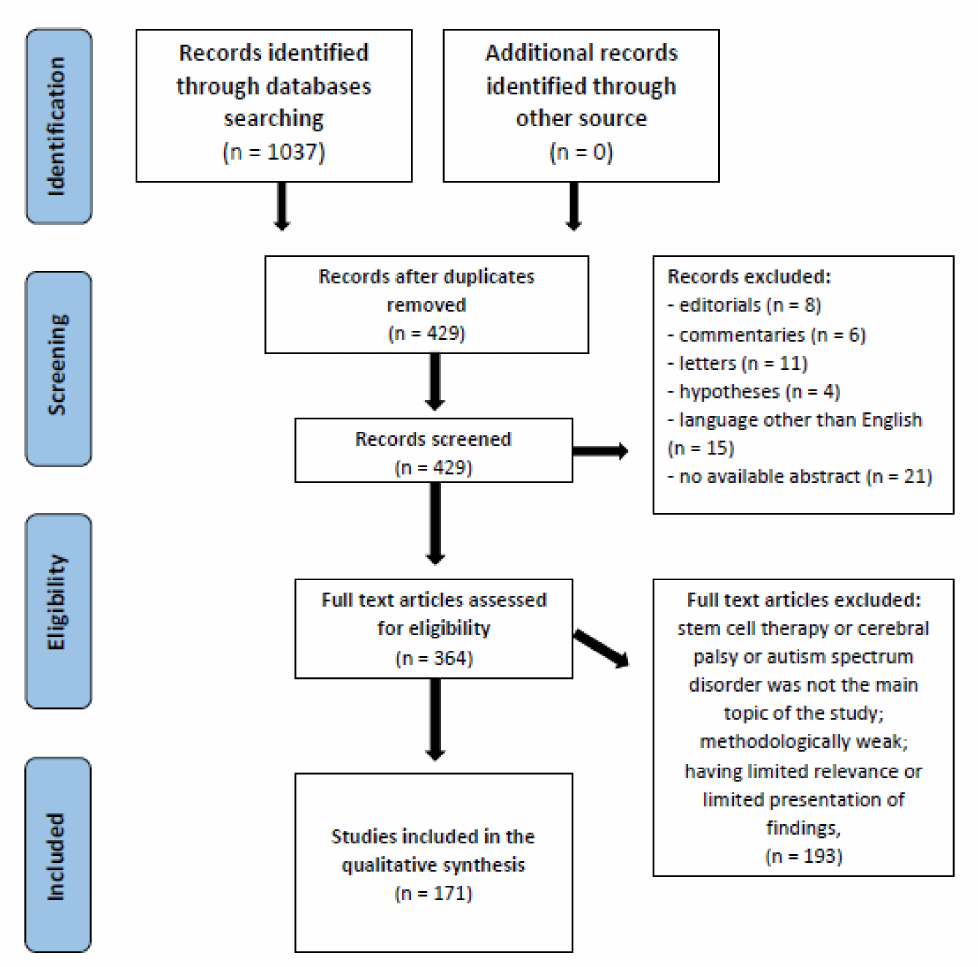
Figure 1. Flow diagram of PRISMA for the strategy research and selection processes for this